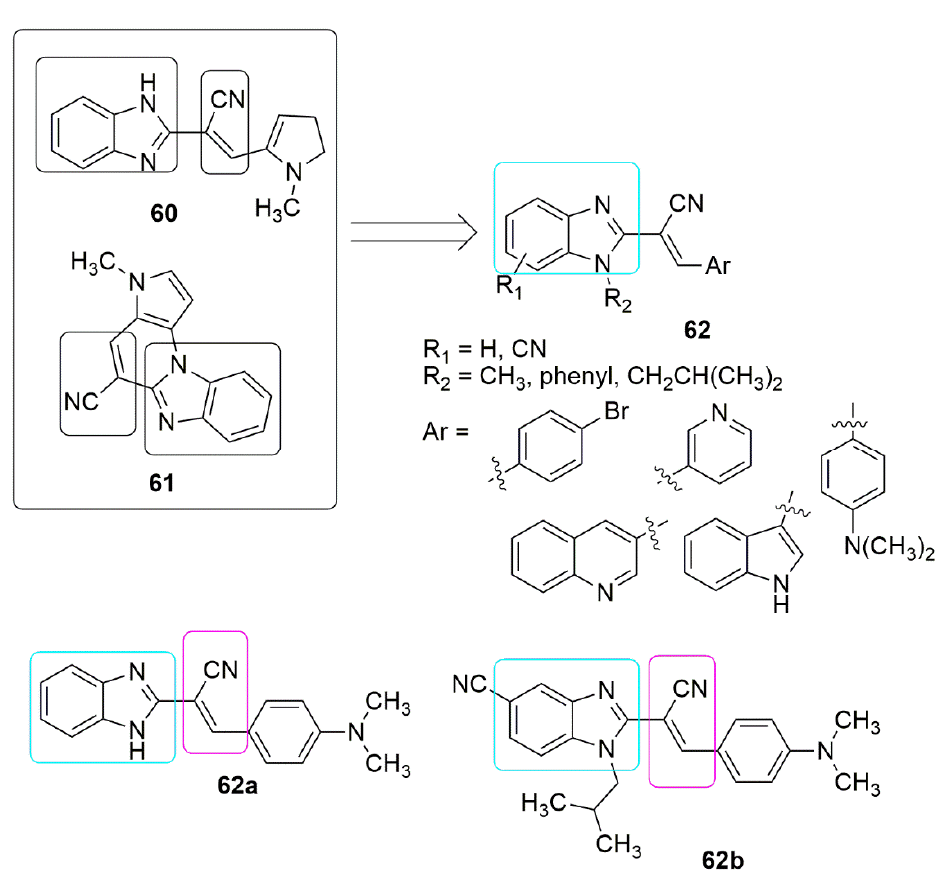
Figure 19. Chemical structures of N -substituted-2-benzimidazolyl acrylonitriles hybrids. Table 4. Antiproliferative activity of compounds 28a and 28b measured in IC50 values ( µ